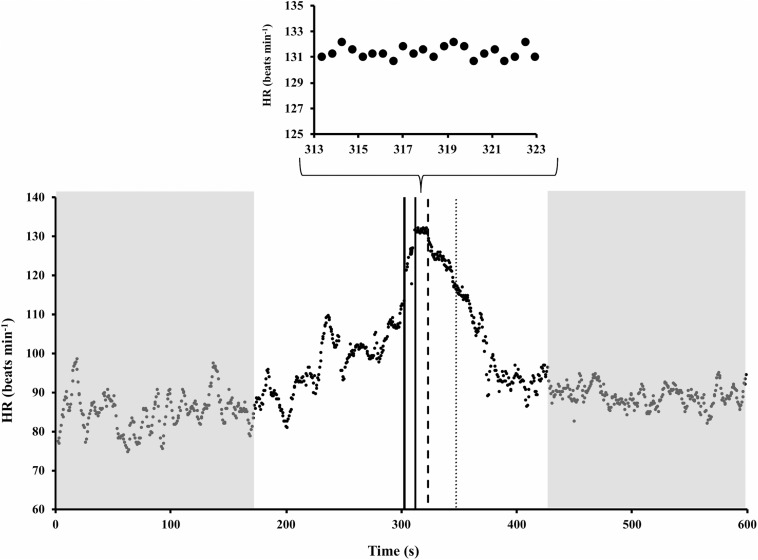
Example of heart rate (HR) time course during standing rest, 60-m sprint, and standing recovery (redrawn from Storniolo et al., 2017). Shadow gray areas represent the time periods for HR variability analysis. It is apparent that in those periods HR was stationary. Solid vertical lines mark the start and end of the sprint. Dashed line marks the onset of HR exponential decay; thus, its distance from the last solid line represents tdelay. Dotted line is set at the time in which the HR decay was 63% completed, so that its distance from dashed line represents τoff.